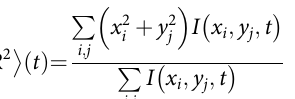
Figure 2 | Electron and hole dynamics. Scanning ultrafast electron microscopy (SUEM) images of the dynamics of ( a ) electrons and ( b ) holes in p -type and n -type silicon, respectively. The images show the unperturbed signal (at (cid:2) 200ps) and the excitation (at time zero), ultrafast expansion (electrons: 33 (cid:2) 260ps; holes: 67 (cid:2) 260ps), and steady-state carrier diffusion (beyond 260ps). Since the maximum brightness is achieved at 50ps in a and 107ps in b , the carrier diffusion is more clearly visible after these times. A comparison of the electron and hole dynamics at the same time delays is given in Supplementary Fig.